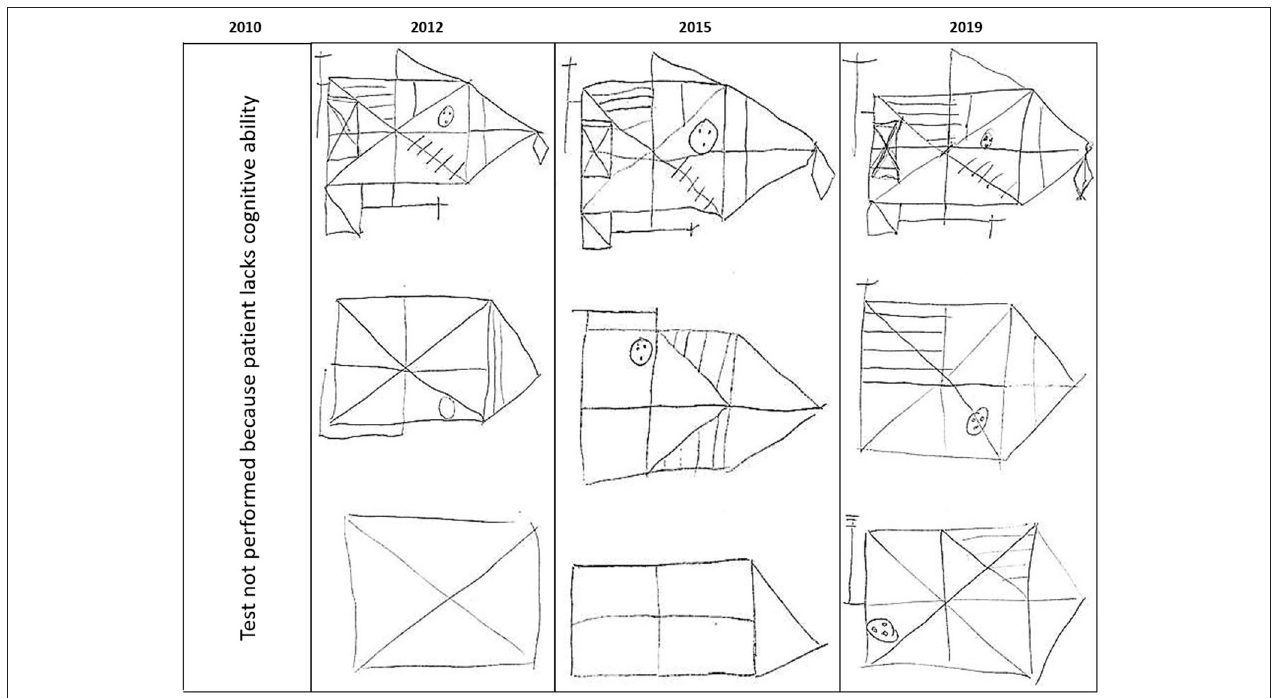
FIGURE 3 | Performance on Rey